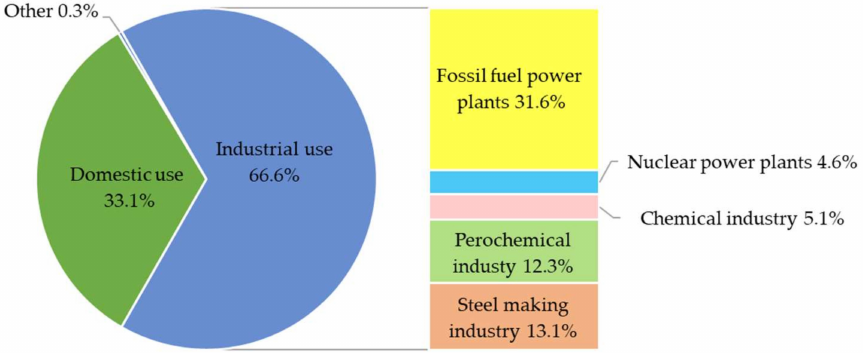
Figure 5. Distribution of desalinated water use in 2016 (Based on